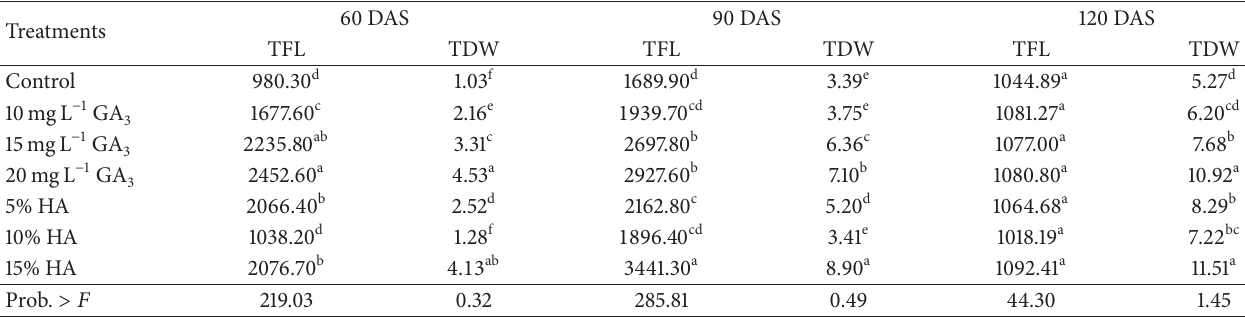
) and humic acid 3